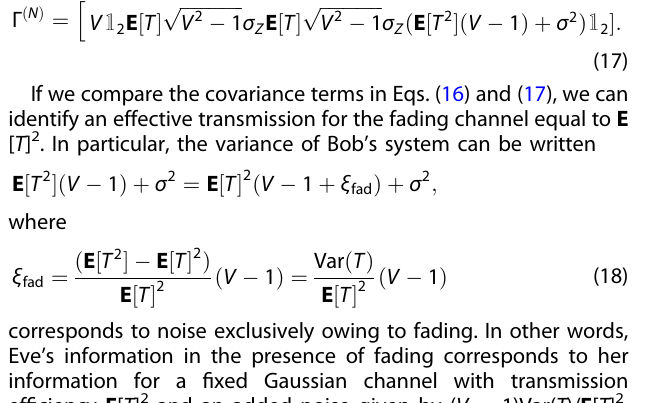
Table 1. Parameters summary.